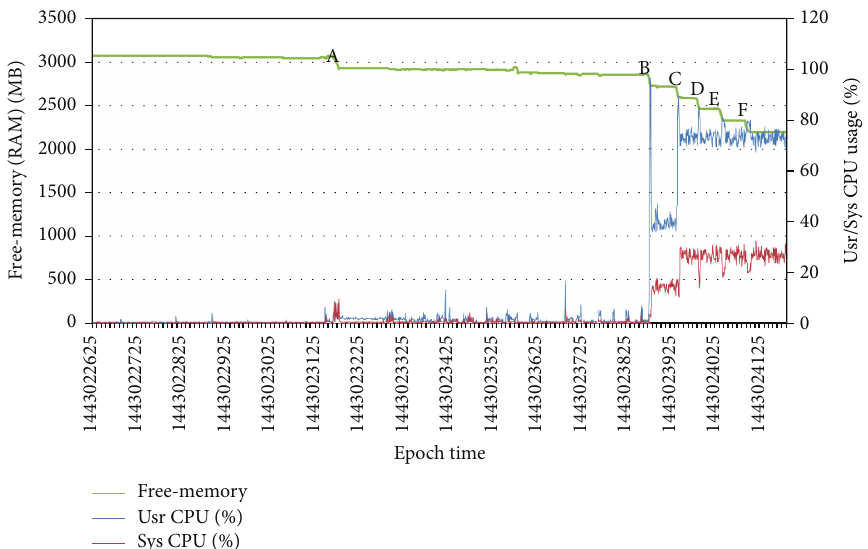
Figure 13: Memory and CPU loading characteristics for the scenario of 5-honeypot container hot spares and subsequent deployment.